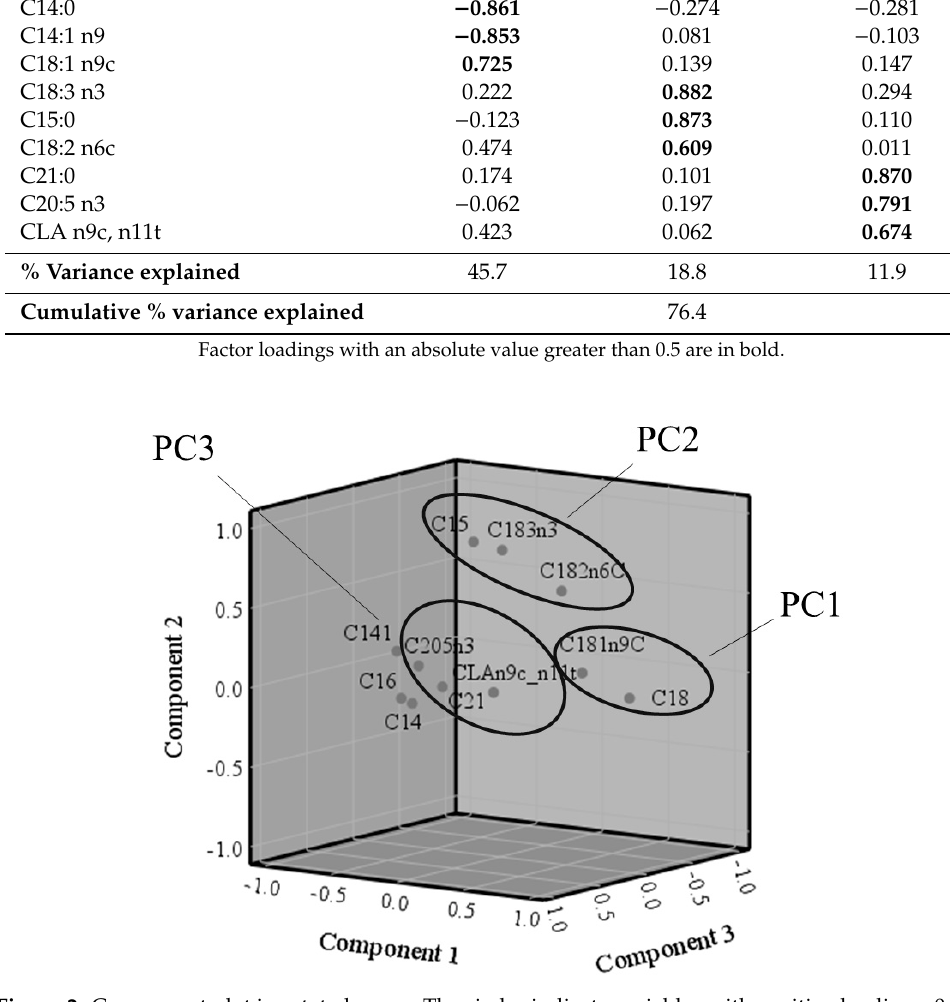
Figure 2. Component plot in rotated space. The circles indicate variables with positive loading > 0.8 for each principal component.